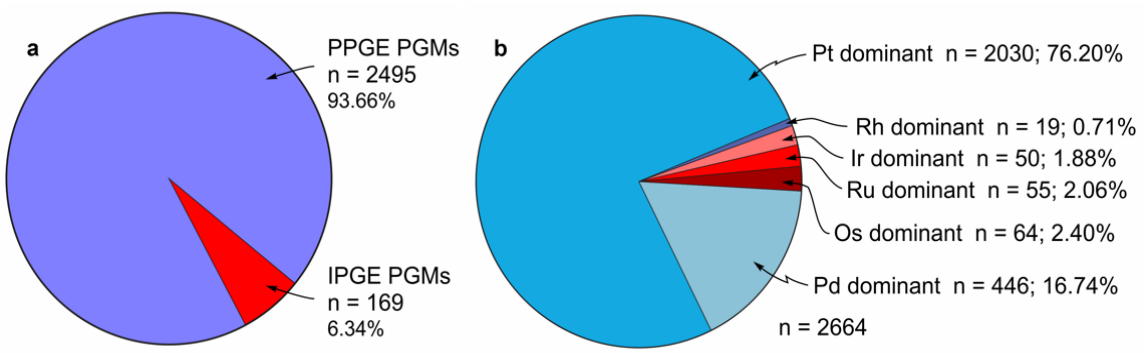
Figure 4. Abundance of platinum-group minerals (PGMs) recovered in heavy mineral super-concentrates obtained after processing till samples. ( a ) PGMs are divided into two major groups: palladium-like platinum-group elements (PPGE) PGMs, whose compositions are dominated by Pd, Pt, and/or Rh, and the iridium-like platinum-group elements (IPGE) PGMs, in which Ir, Os and/or Ru are major components. ( b ) PGMs in which Pt is the dominant metal represent 76.20% ( n = 2030), whilst Pd is the dominant metal for 16.74% ( n = 446) of the PGM population recovered from till in this study ( n = 2664).